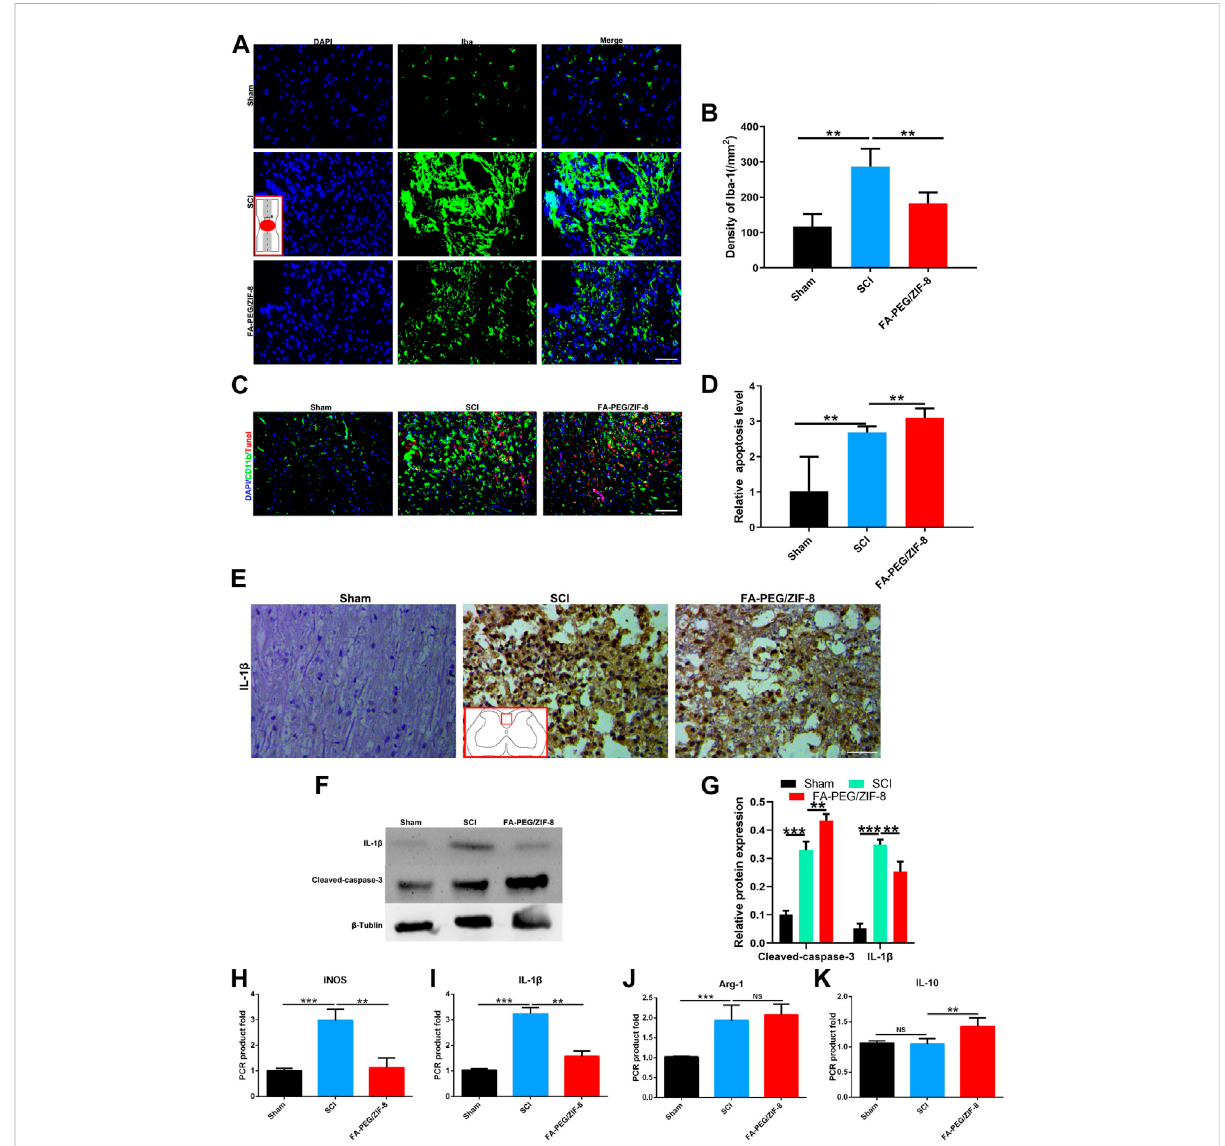
FIGURE 5 Anti-in fl ammation effect of FA-PEG/ZIF-8 in SCI mice. Representative images (A) and quanti fi cation analysis (B) of Iba-1 in the spinal cord. Representative images (C) and quanti fi cation analysis (D) of Tunel in the spinal cord. Representative images (E) of IL-1 β in the spinal cord. Representativeimages (F) andquanti fi cationanalysis (G) ofIL-1 β andcleaved-caspase-3inthespinalcord via Westernblot.Quanti fi cationanalysisof iNOS (H) , IL-1 β (I) , Arg-1 (J) , and IL-10 (K) mRNA levels in the spinal cord. Scale bars, 100 µm. Data are presented as the mean±SD.